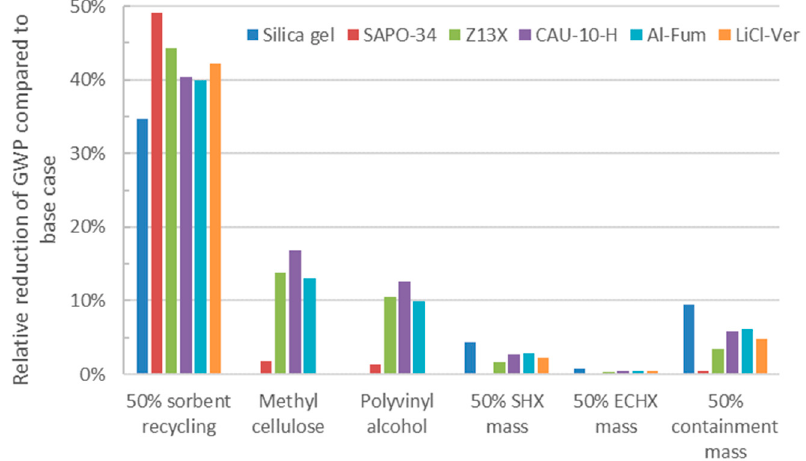
Figure 13. Influence of different measures on GWP of the studied storage configurations.